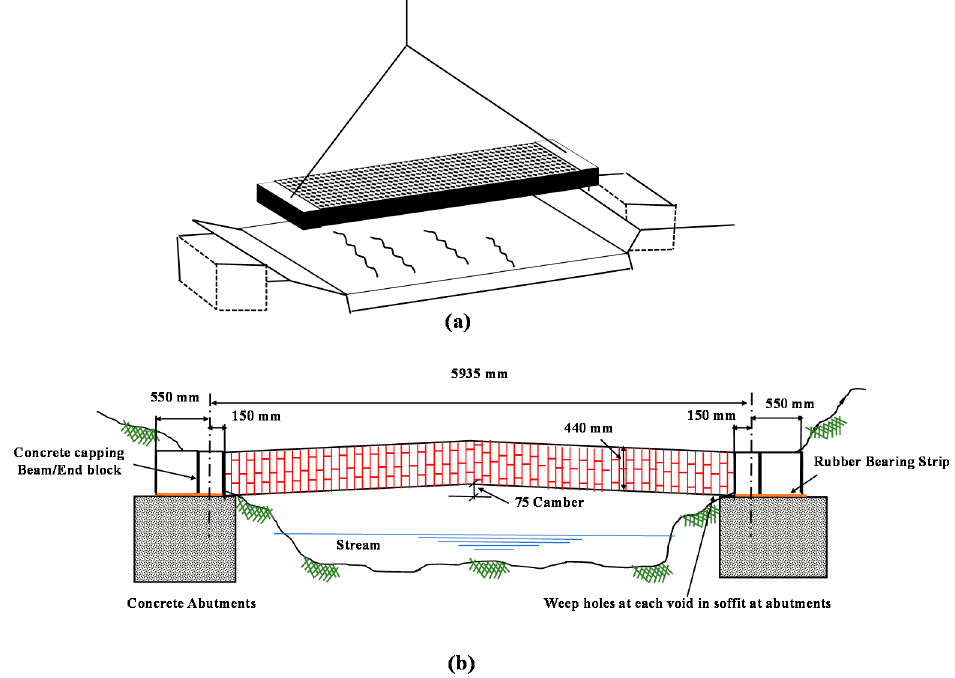
Figure 5. Prefabricated PT masonry bridge decks used (Caine): [53] ( a ) positioning of prefabricated masonry deck and ( b ) cross sectional view of the deck.